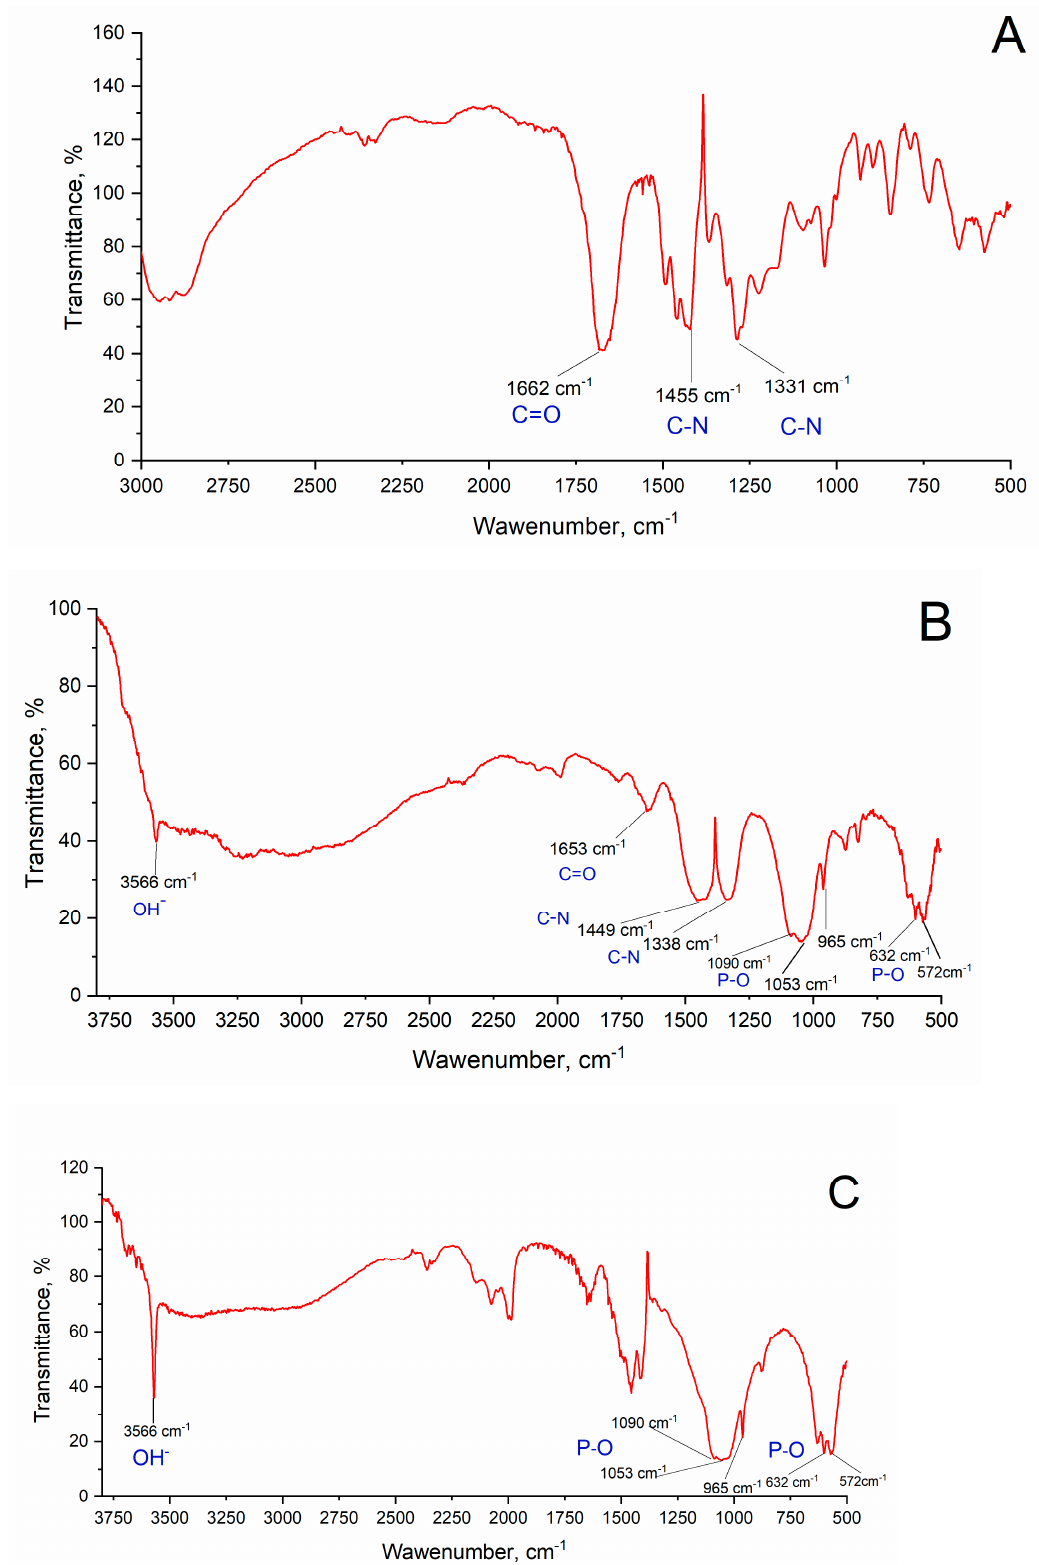
Figure 4. IR spectra of ( A ) PVP, ( B ) composite sample 3 (Table 1) and ( C ) sample 3 after annealing at 400 ◦